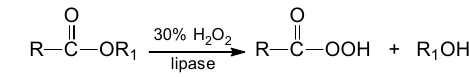
Scheme 3. The reaction of carboxylic acids esters with hydrogen peroxide.